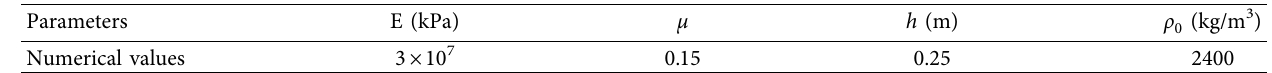
Table 2: Plate paremeters.